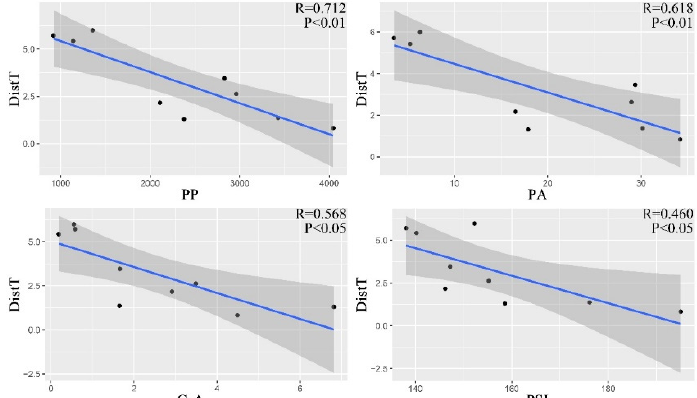
Figure 3. Correlation of park perimeter (PP), park area (PP), grass area (GrA), and park shape index (PSI) with distance from the third ring road (DistT). R expresses the degree of explanation of the relationship between the 2 variables, and it indicates a significant correlation between the two variables when p < 0.05.